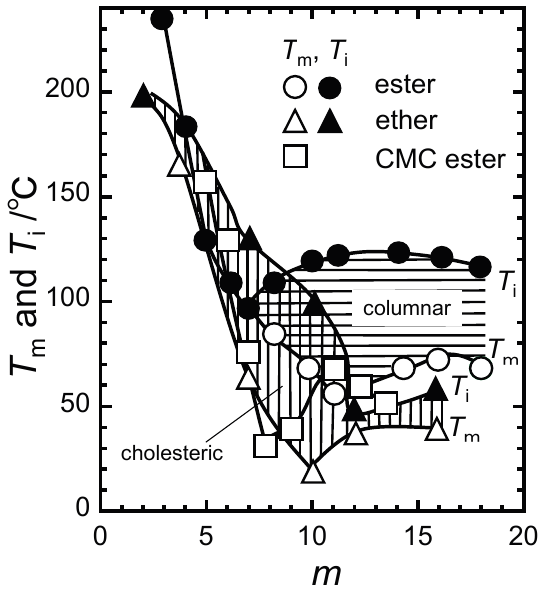
Figure 3. Melting temperature T m and isotropization temperature T i of normal alkyl ester and ether derivatives of cellulose. Ester derivatives of tri- O -carboxymethyl cellulose (CMC) hardly form a mesophase regardless of m . Reproduced with permission from ref.